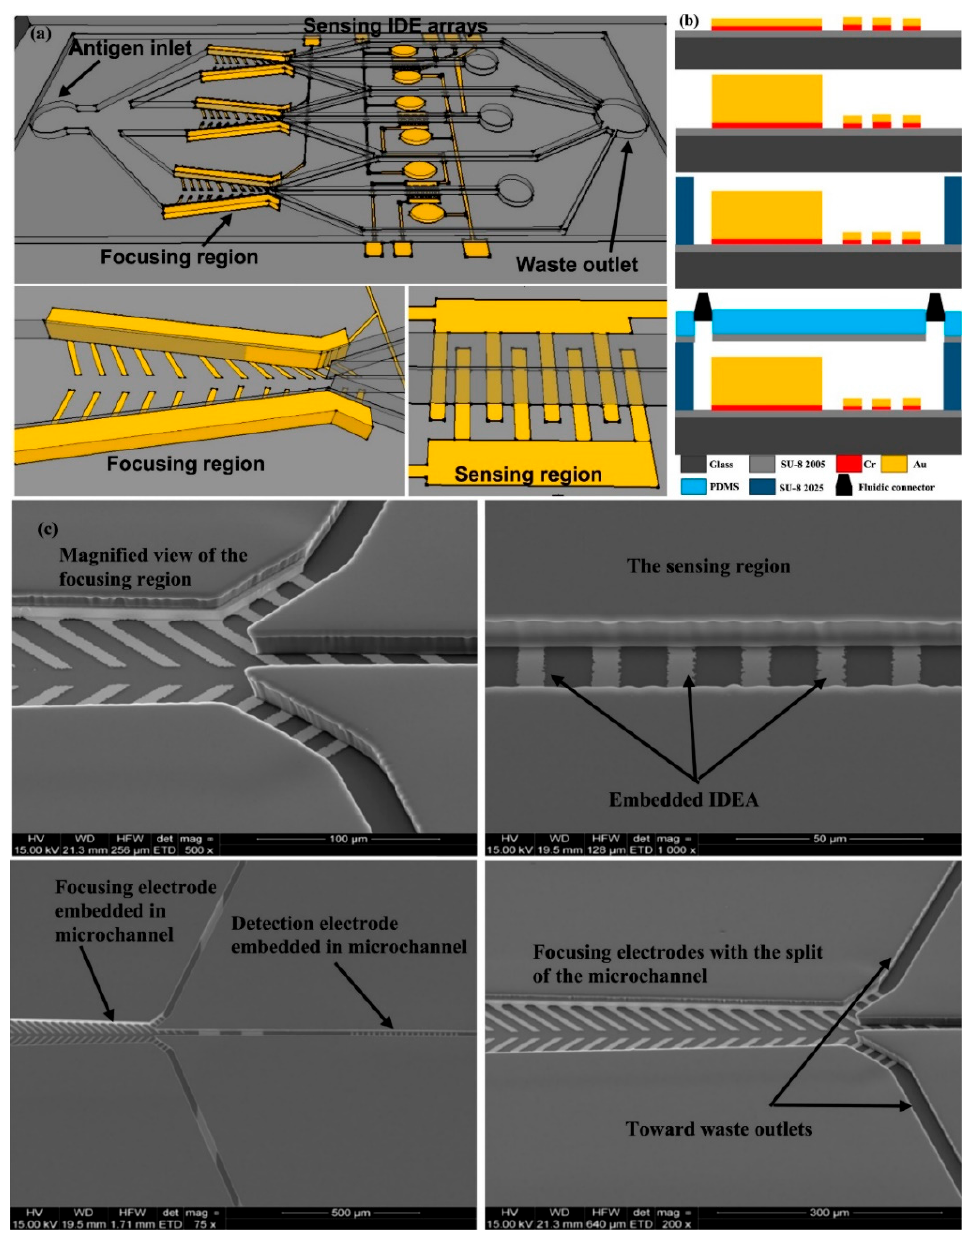
Figure 7. Impedance-based biosensor for Salmonella detection. ( a ) Representation of sensor based upon impedance, zoomed image of focusing and detection electrodes; ( b ) Image showing cross- sectional analysis of the layers fabricated in the biosensor including electroplated vertical walls, thin film electrodes with patterned structure, PDMS cover, fluidic connectors and SU8 2025 microchannel ( c ) SEM image of the fabricated device explaining the enlarged view of the detection region and focused region depicting the microchannel split. Adapted with permission from Ref. [100]. Copyright 2017, Elsevier.